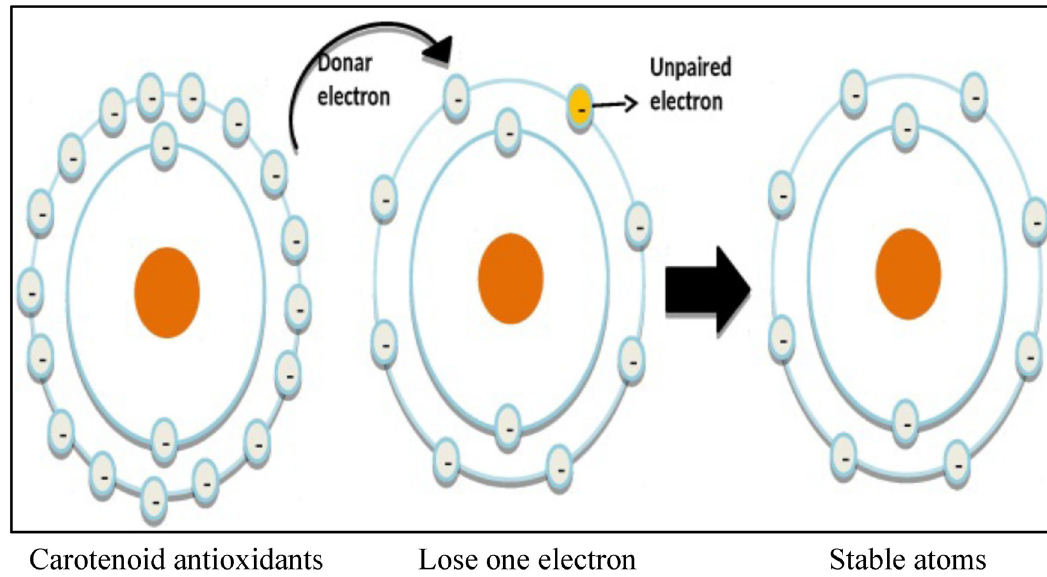
Figure 4: Carotenoid mechanism neutralizes free radicals [ 30 ] : carotenoid antioxidants, lose one electron, stable